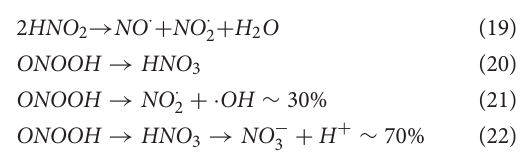
inactivation beyond its theoretical lifetime. Since ONOOH and HNO 3 are isomers, it is not possible to detect ONOOH via UV spectroscopy, Raman spectroscopy, or mass